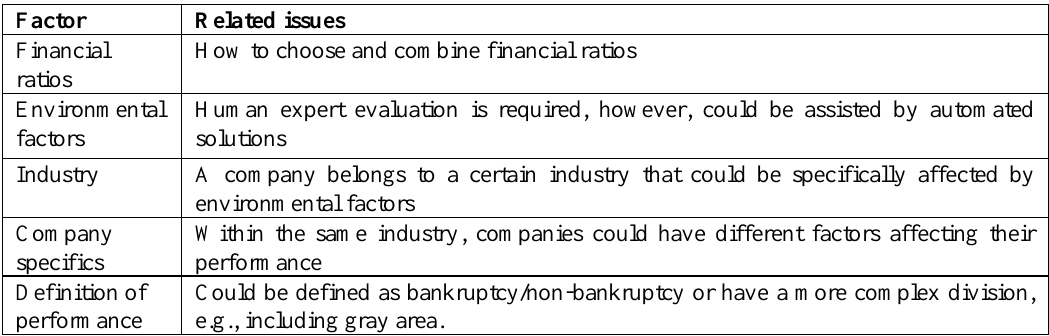
Table 10. Extended criteria for company performance